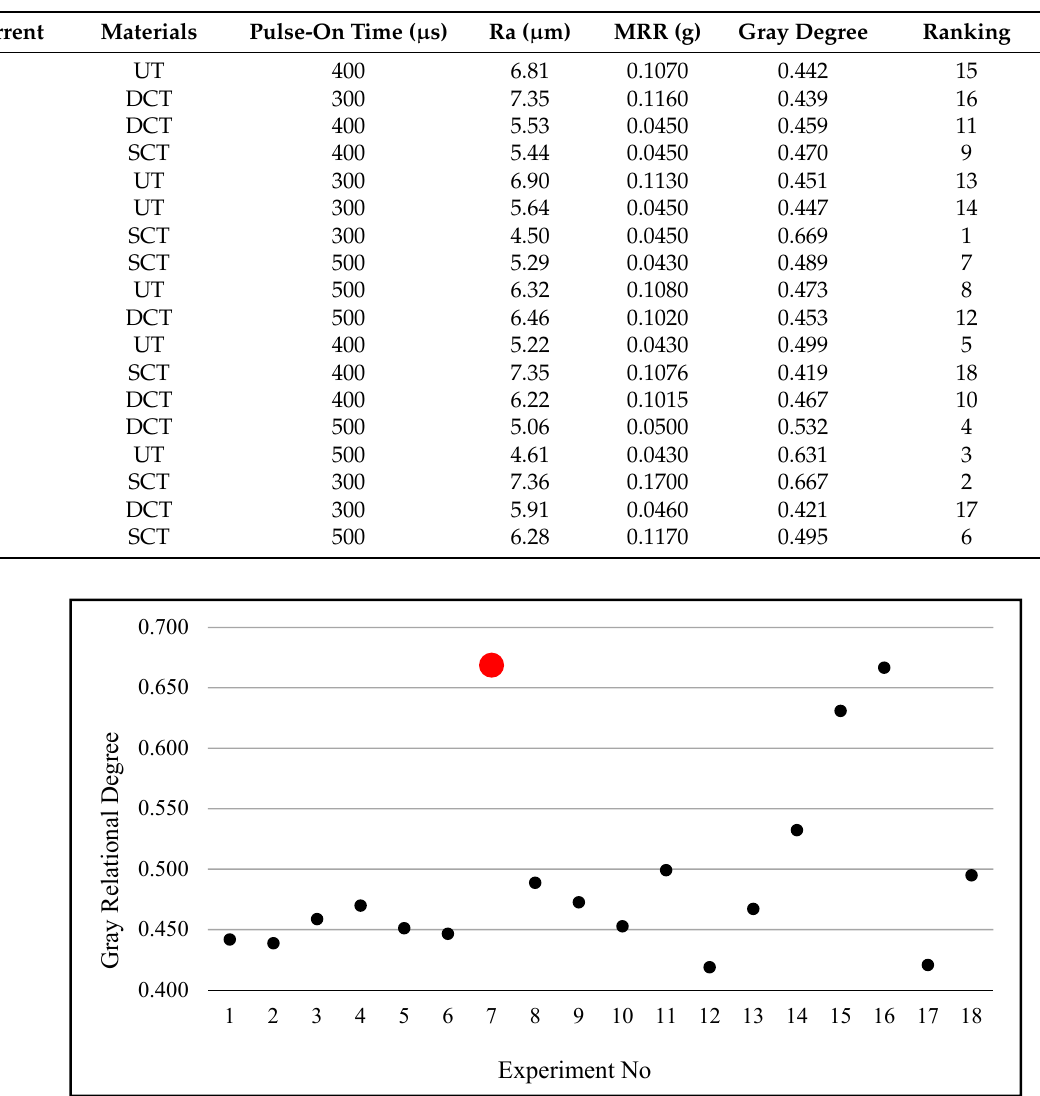
Table 13. Gray associative grades and ordering for average surface roughness and MRR.